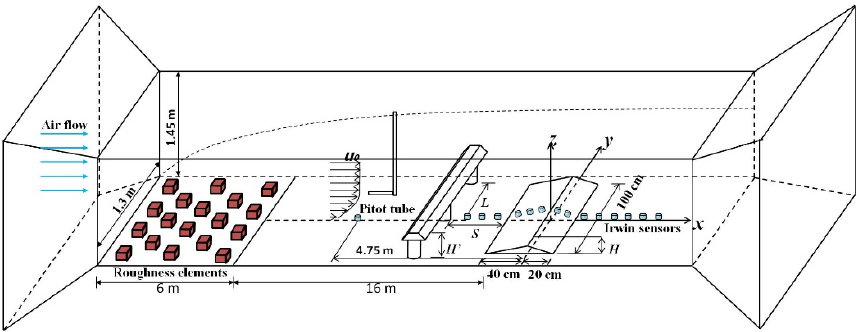
Figure 2. Schematic diagram of wind tunnel experiment.